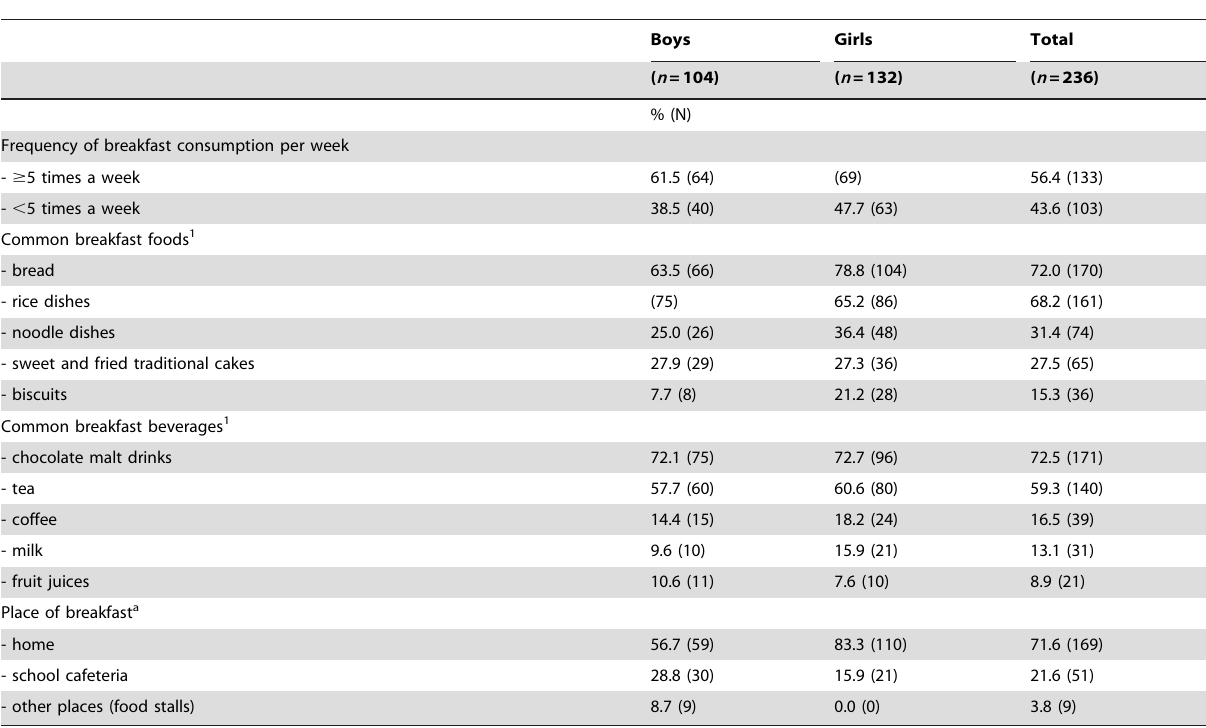
Table 2. Breakfast consumption of male and female